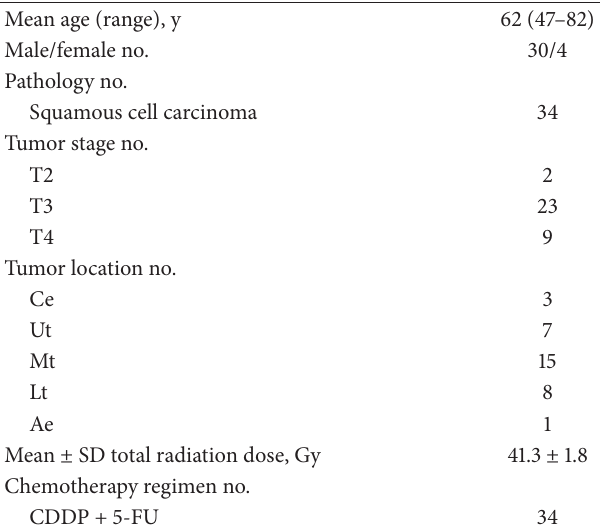
Table 1: Patient and tumor characteristics ( 𝑛 = 34 ). Mean age (range), y 62